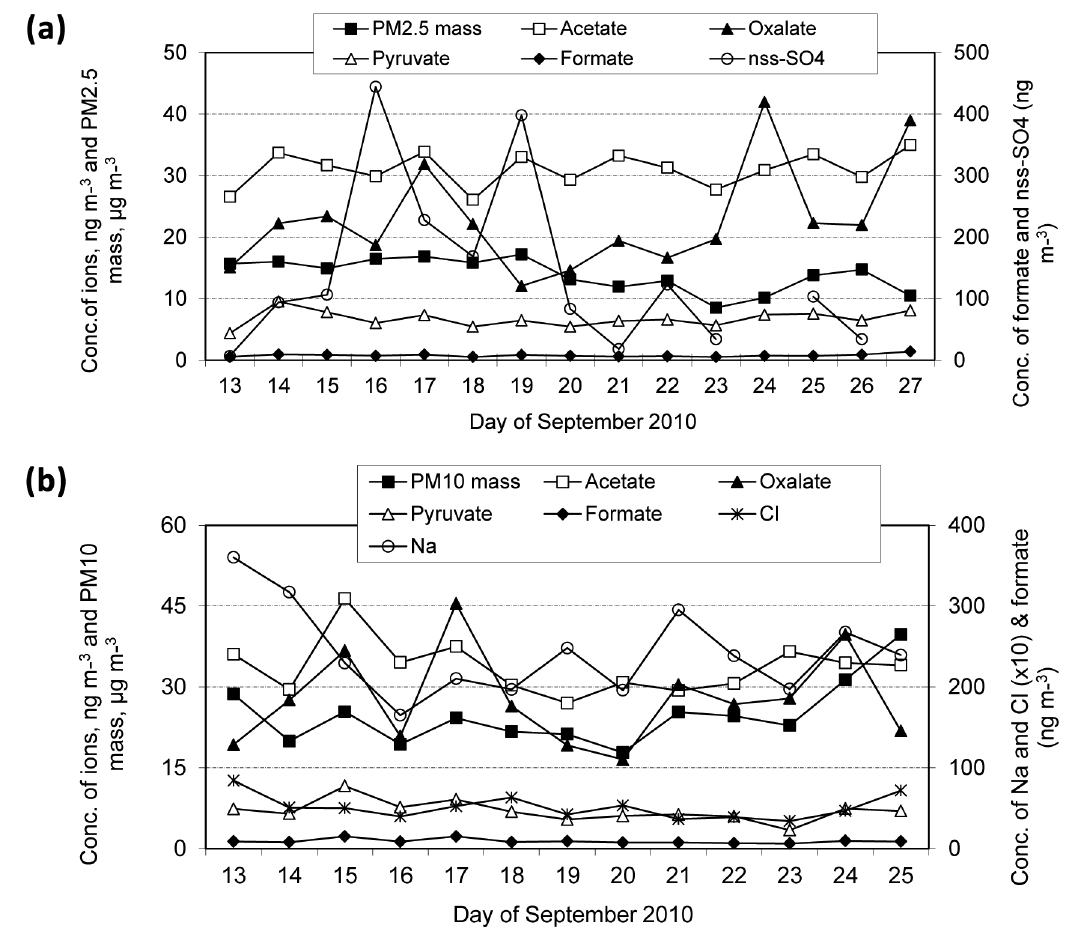
2− in the PM2.5 size fractions (a) and in the PM10 size 4